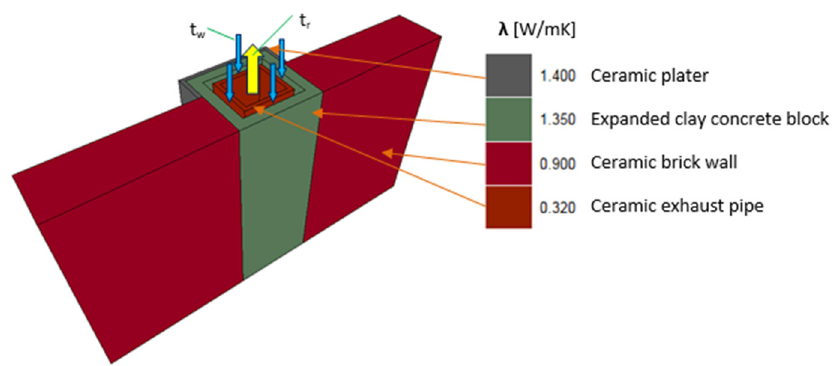
Figure 10. Calculation model.